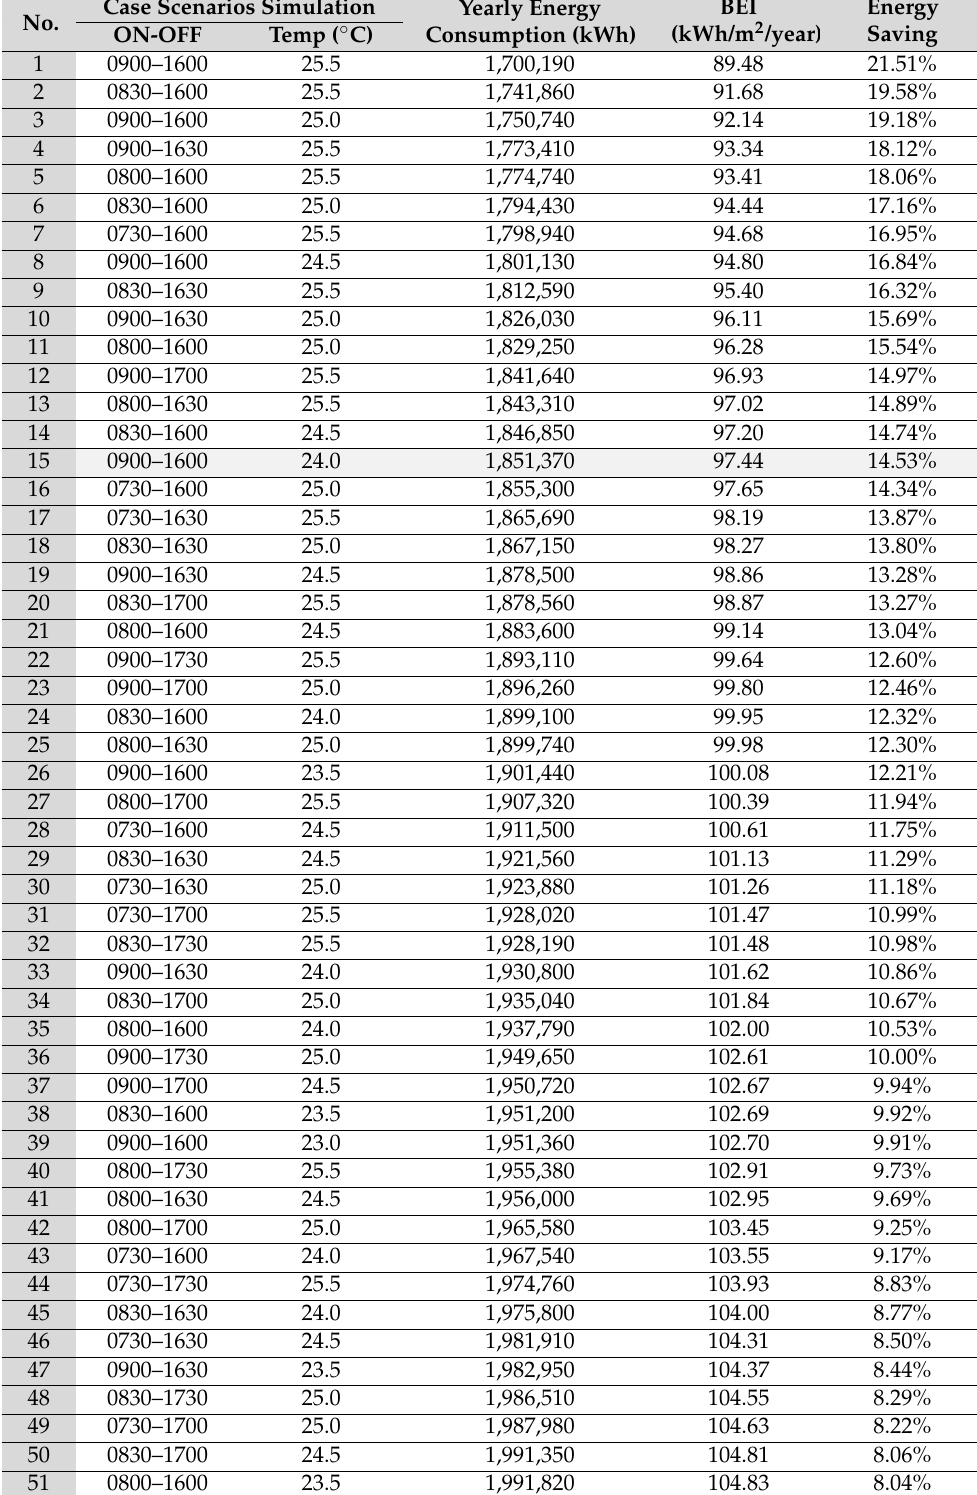
Table 9. Simulation scenarios with various chiller temperatures to achieve energy efficiency. Case Scenarios Simulation